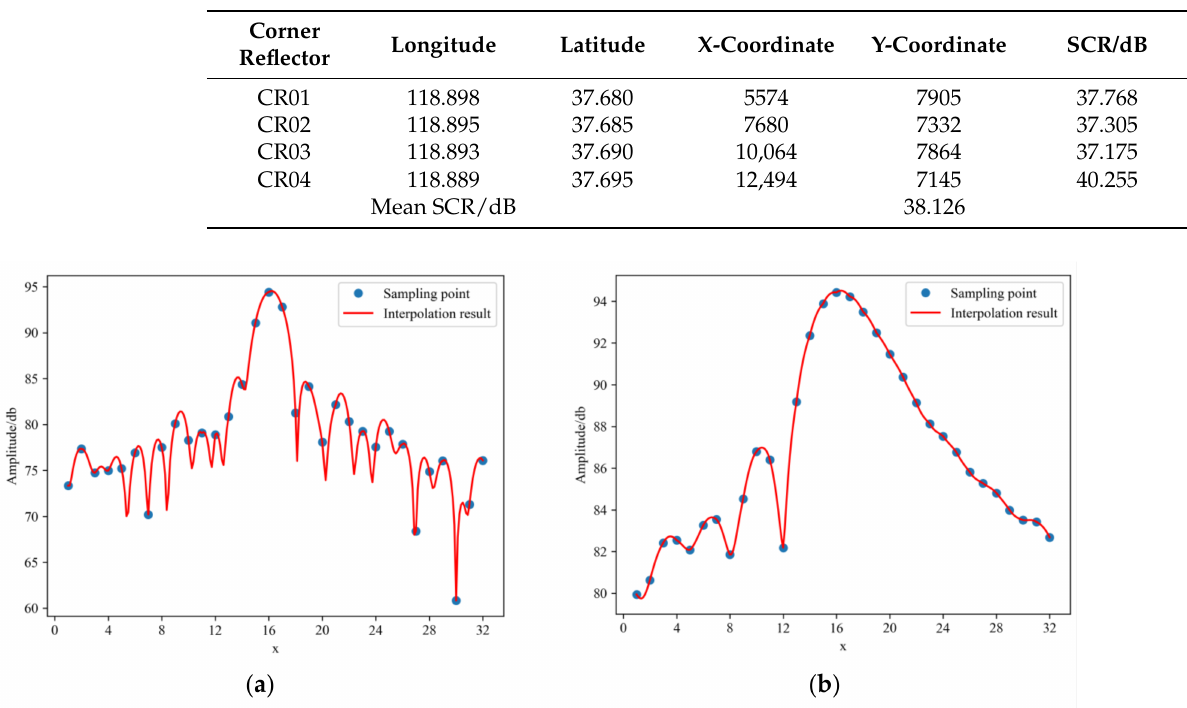
Figure 9. CR03 one-dimensional profile of the impulse response in the range and azimuth directions in the VV polarimetric image: ( a ) range direction interpolation; ( b ) azimuth direction